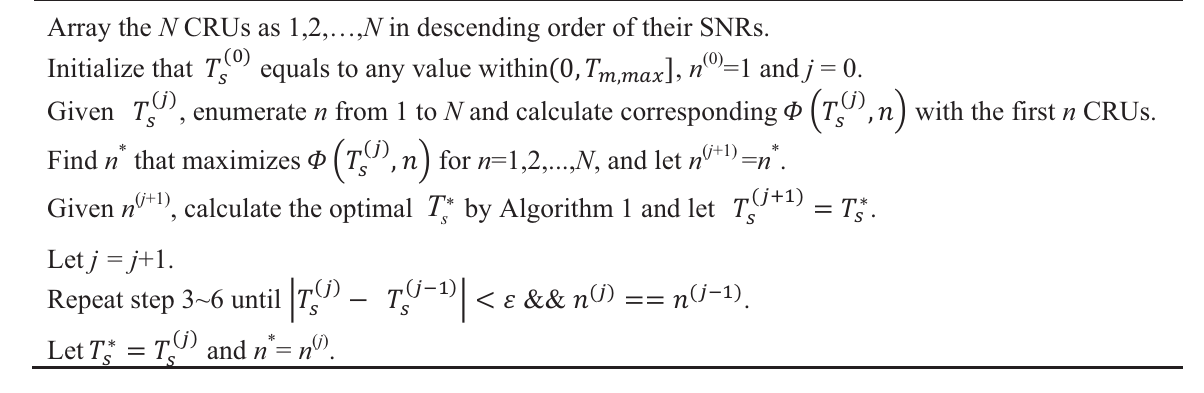
Algorithm 2. Joint optimization algorithm of T